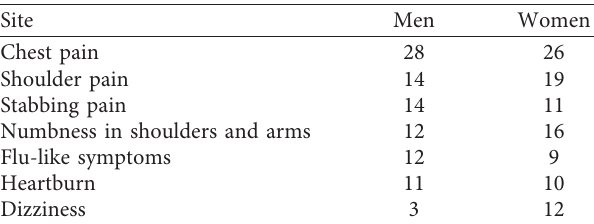
Some responses were approximate. Table 2: Prevalence of symptoms related to acute coronary